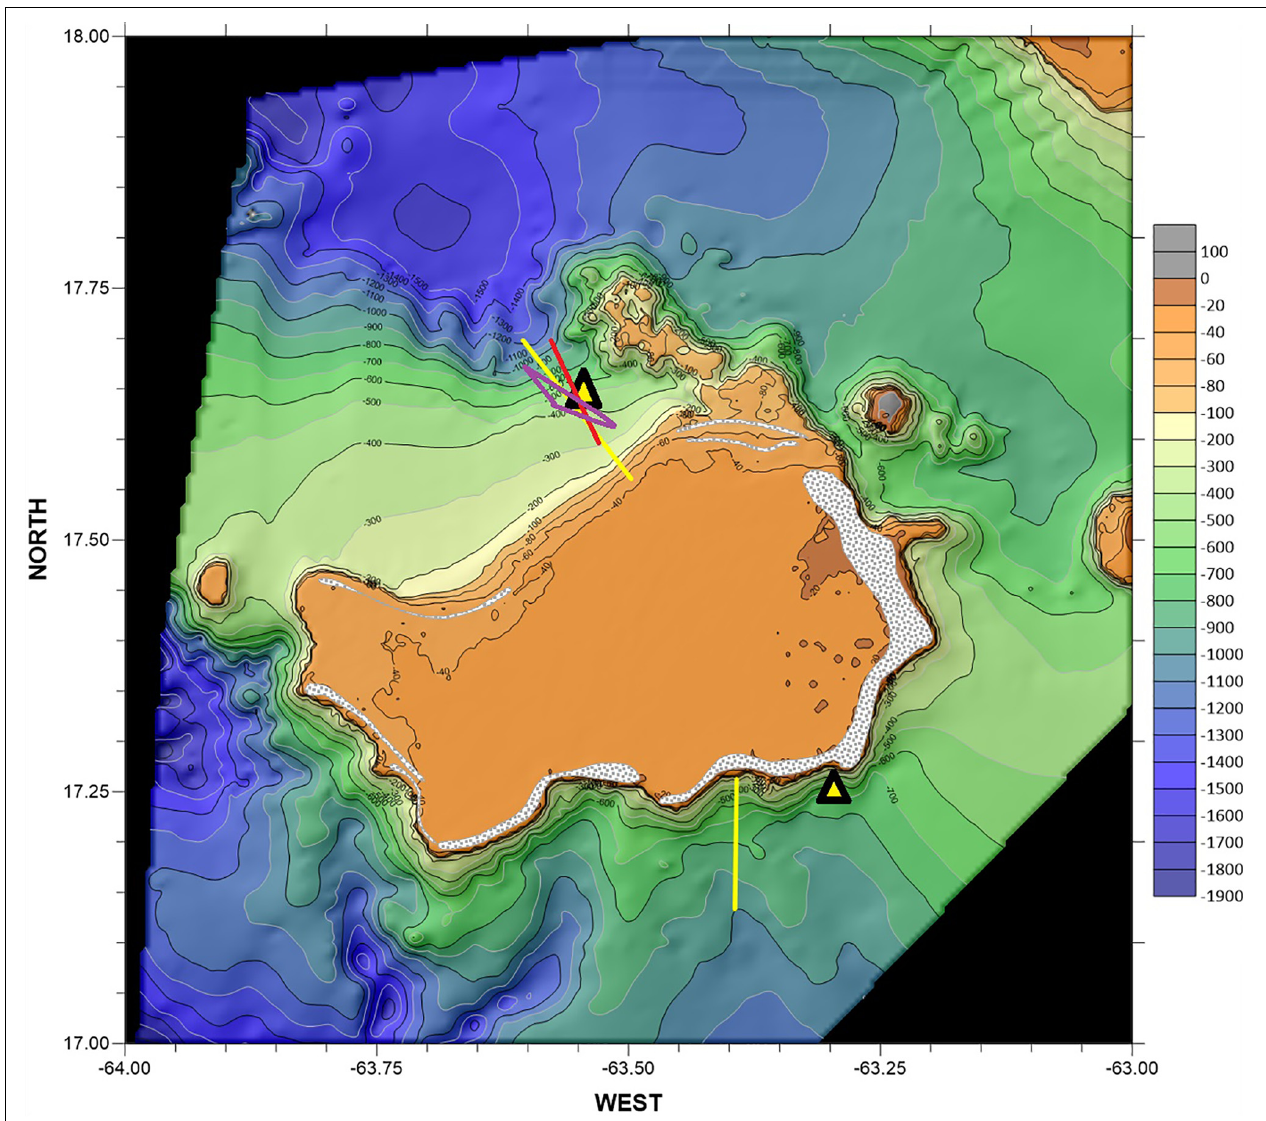
FIGURE 1 | Saba Bank topography from GEBCO data, with mooring locations at the two triangles to the North (MN) and South (MS) of the Bank. Saba island is visible in gray to the northeast of the Bank. The tidal current ellipses near MN are the mean values for the upper (red) and lower (purple) 50 m of the ADCP good-data range. The length of the red rectilinear ellipse is 0.06 m s − 1 . The yellow lines indicate CTD-transects. The dotted areas coarsely indicate the location of coral reefs, drawn after (van der Land,